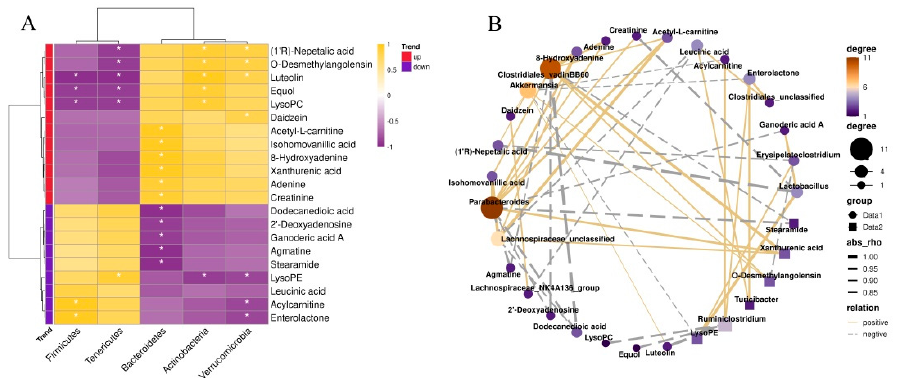
Figure 3. Spearman analysis of the correlation between intestinal microbial composition and intestinal differential metabolites: ( A ) Spearman correlation analysis between genus and metabolite concentrations affected by CPF supplementation. ( B ) Network diagram of intestinal differential metabolites and microbial taxa. * p < 0.05.